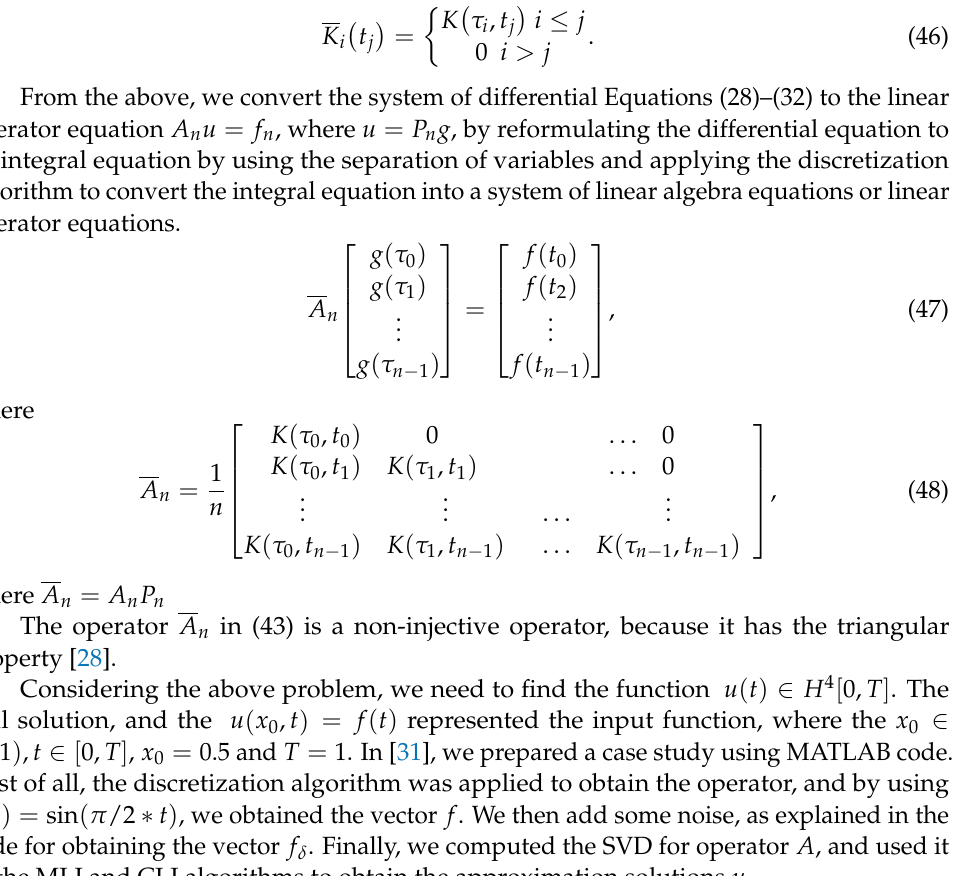
Algorithm 1 MLI (number iteration): MLI the value of the regularization parameter that was used with 1000 iterations (see Figure